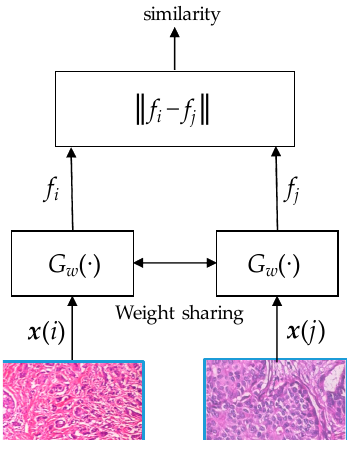
Figure 2. The architecture of Siamese neural network.